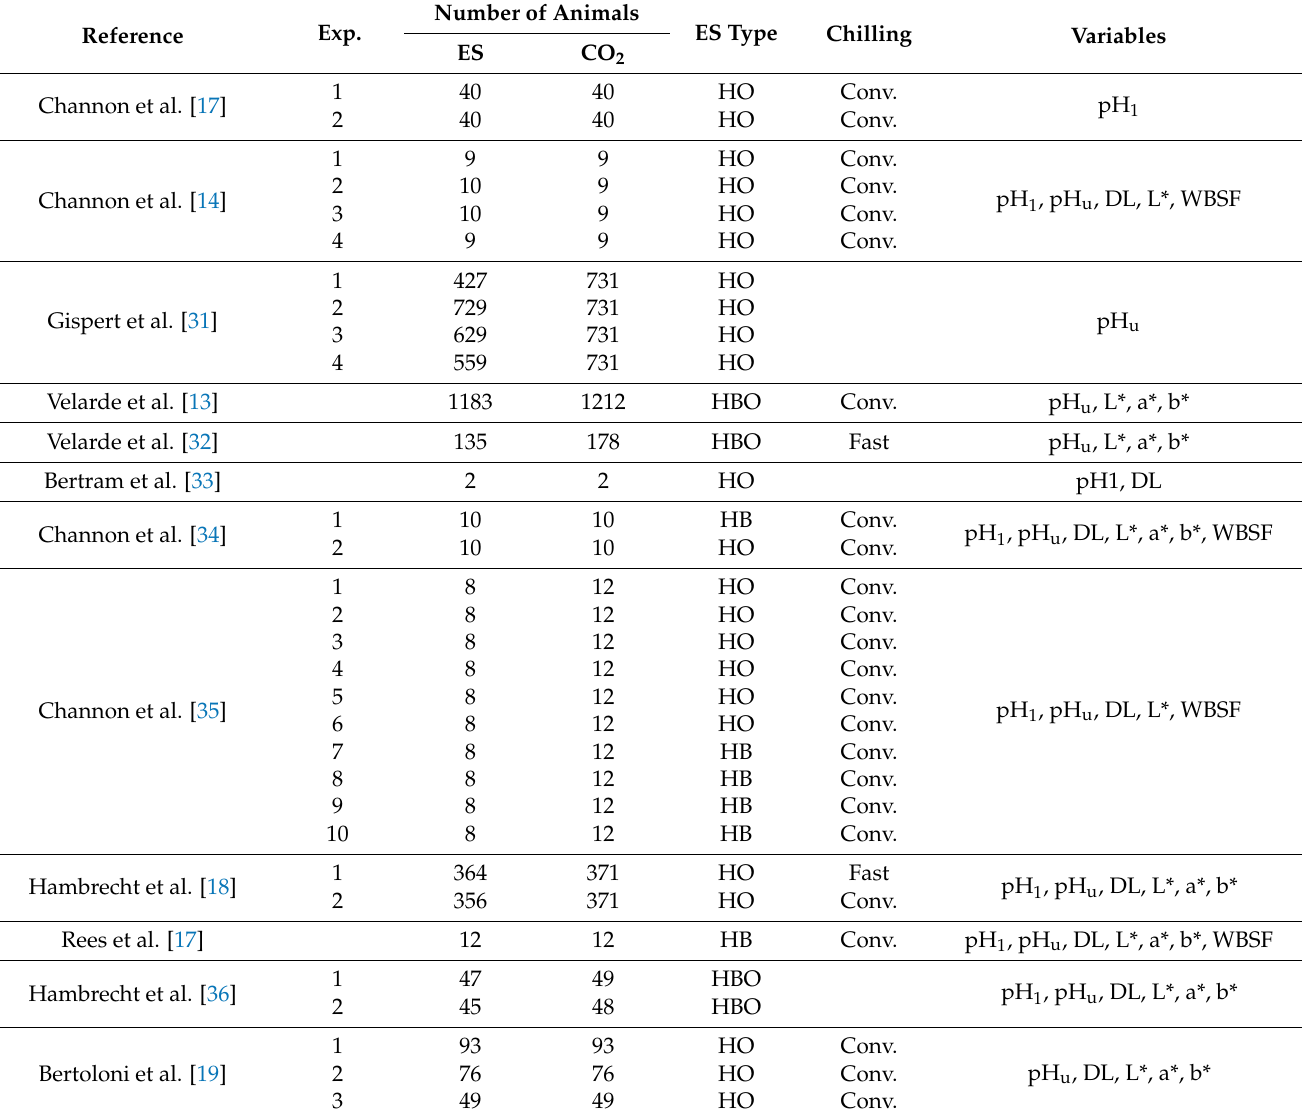
Table 1. Summary of the studies included in the